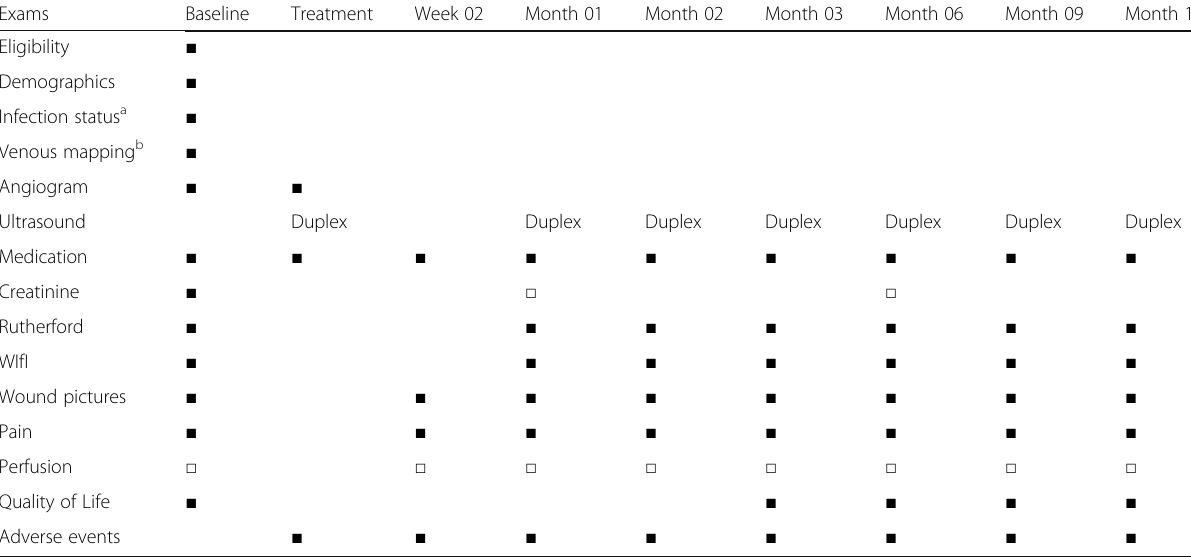
Table 1 Visits and exams Patients should be followed at regular intervals during one year after the initial percutaneous deep vein arterialization procedure in accordance with standard of care and local practice. Visits and exams scheduled for this post-market study are presented in 1 below (keys: ■ mandatory, □